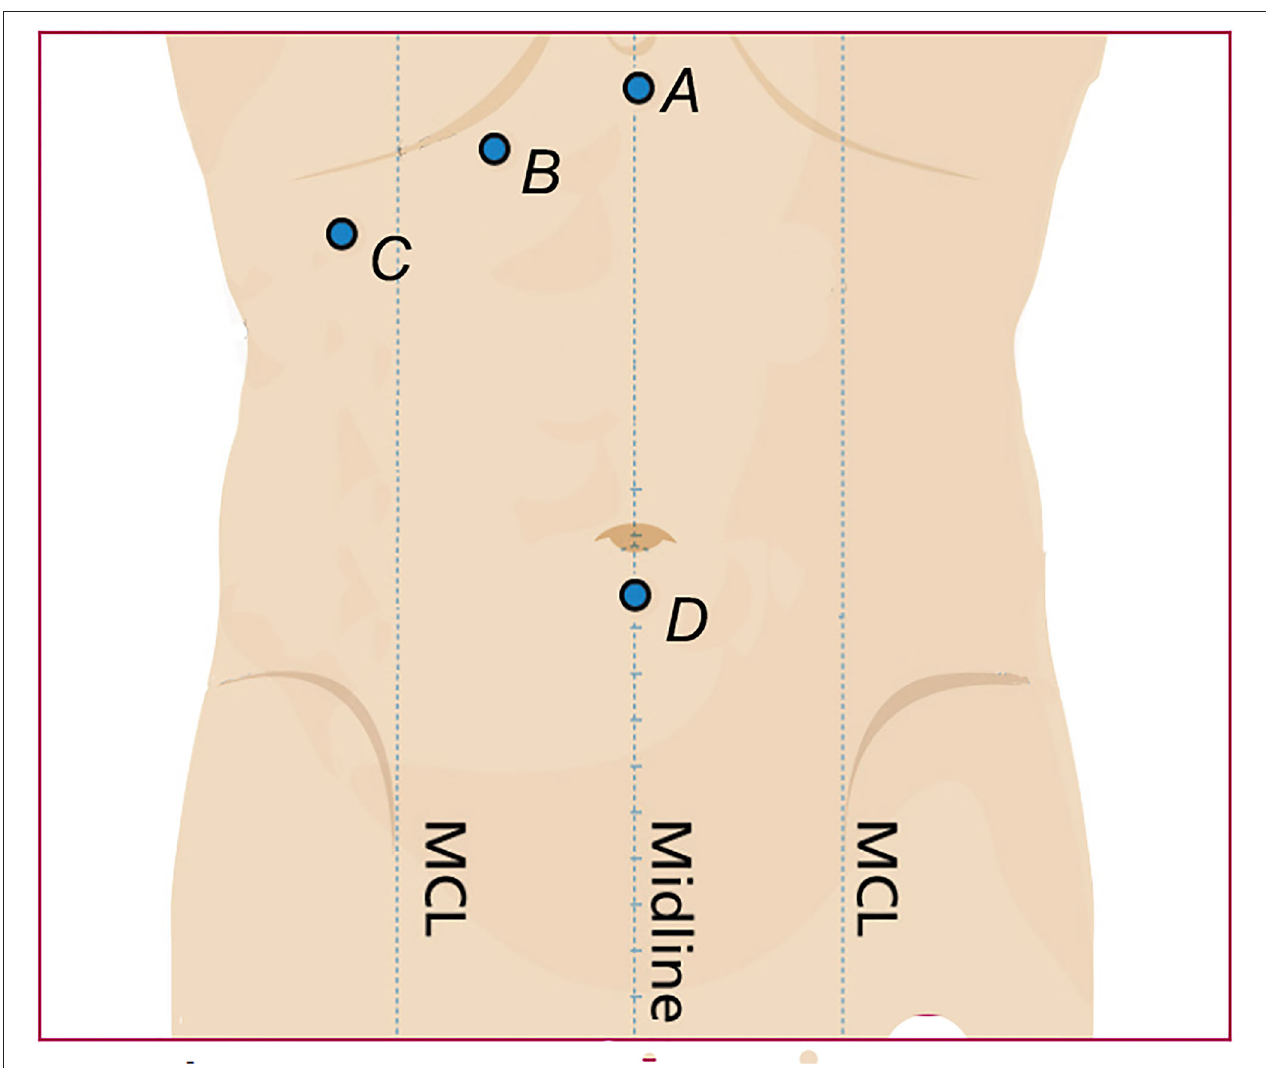
FIGURE 1 | (A) Subxiphoid Trocar, (B) The working passage of the choledochoscope along the subcostal margin of the right clavicular line. (C) An auxiliary hole placed on the axillary front along the lower margin of the rib. (D) The laparoscopic camera port below the